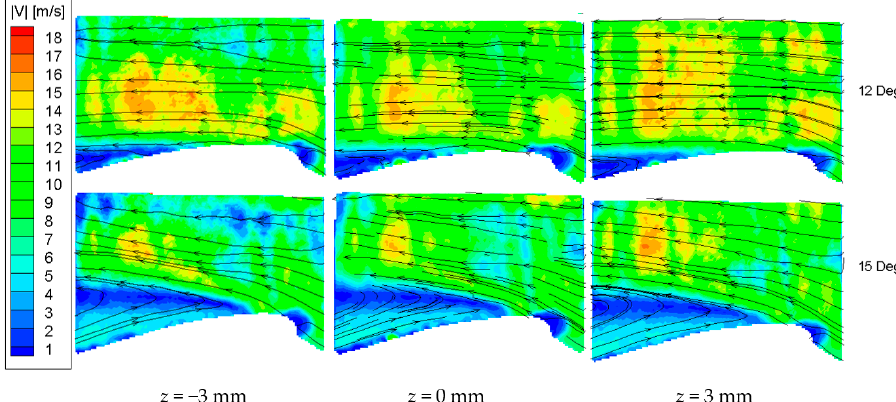
Figure 8. Three sample planes from two-camera 3D reconstruction for the dimpled airfoil at two AoA.